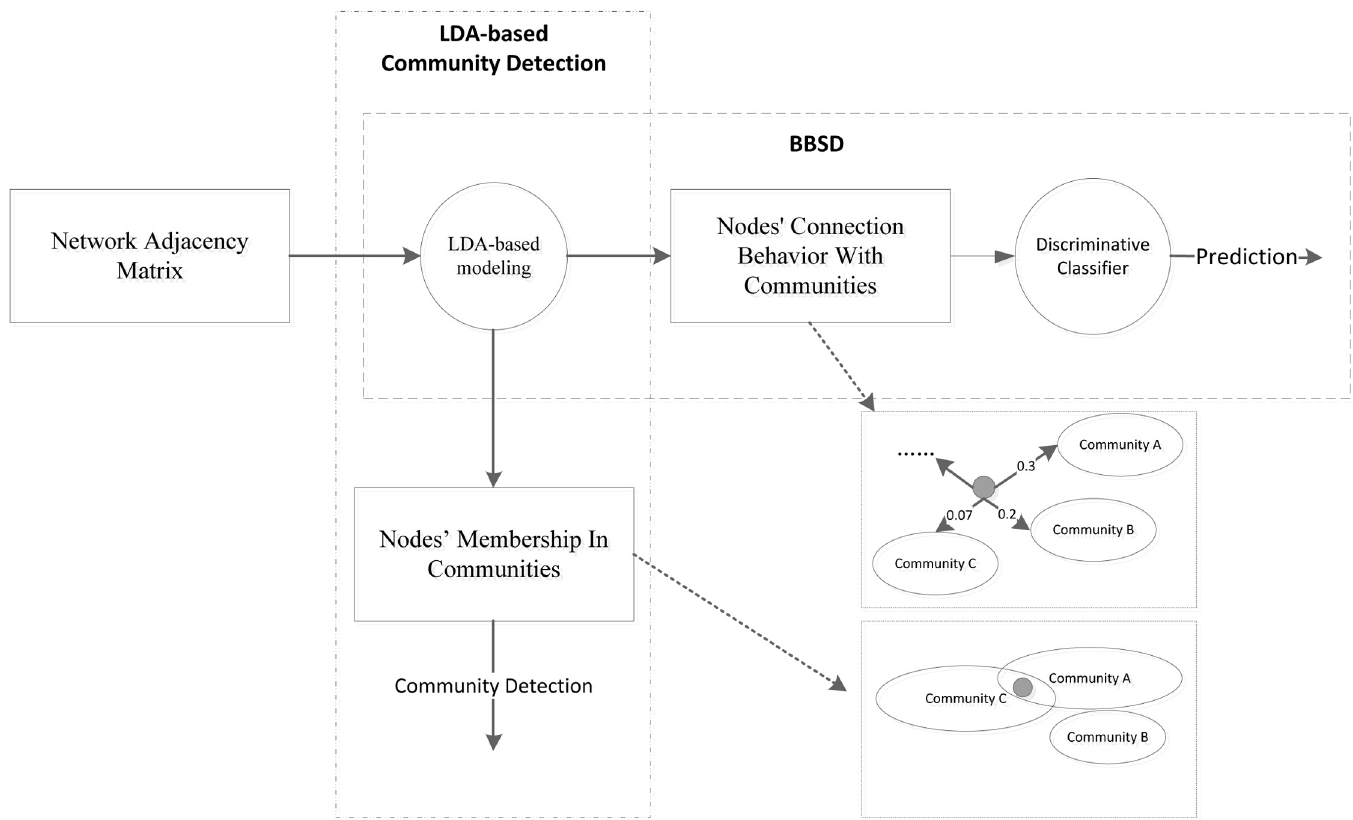
Fig 2. Difference between BBSD and